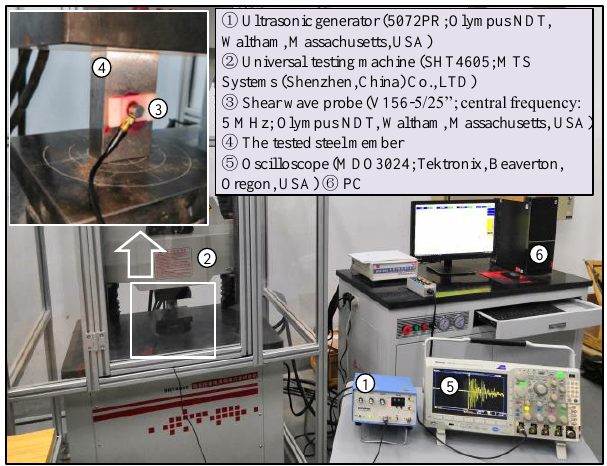
Figure 3. Measurement devices: photographs.